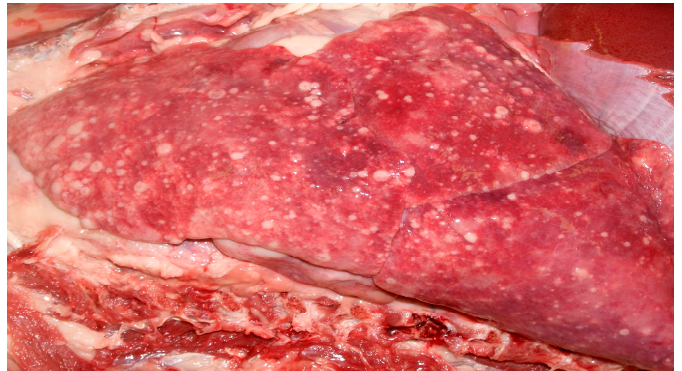
Figure 1. The lungs, in situ, with multifocal pale yellow to white masses.